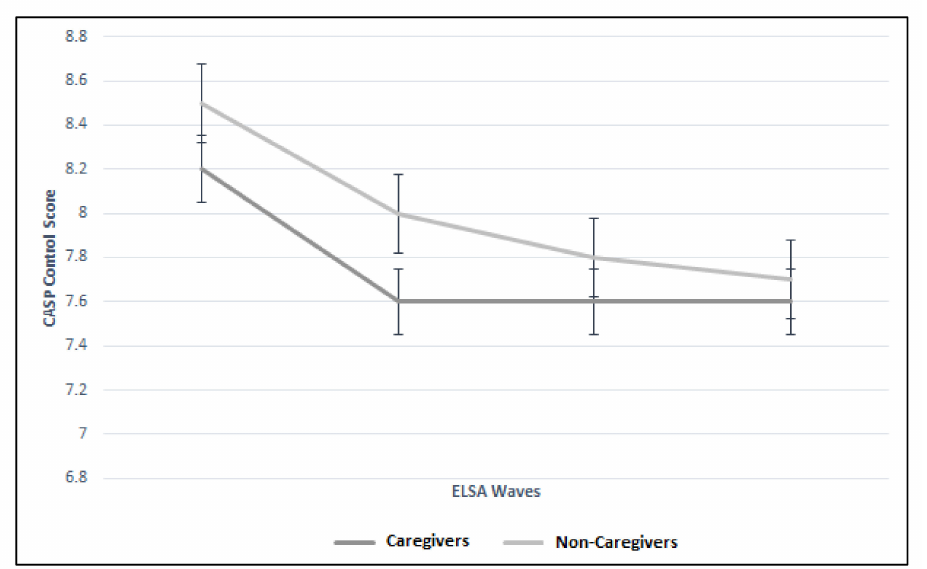
Figure 4. Trajectory of control CASP score between caregiver and non-caregiver cohorts across four ELSA waves.